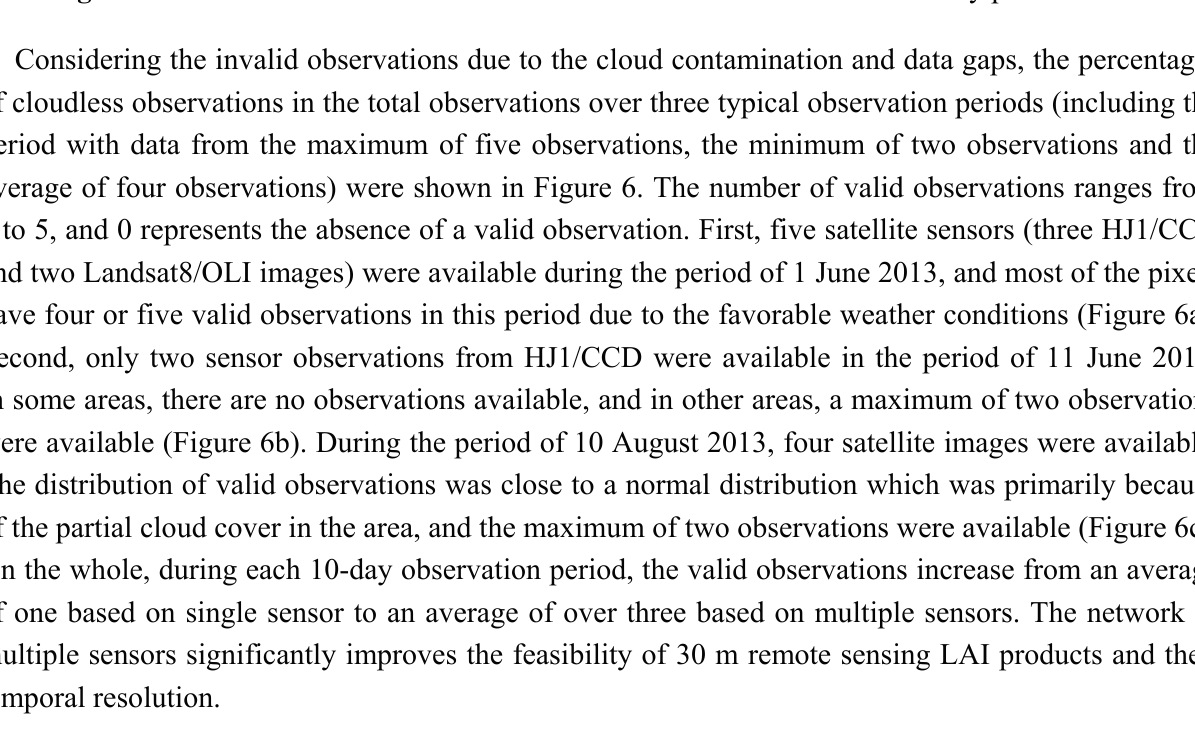
Figure 5. Statistical distributions of the multi-sensor observations in a 10-day